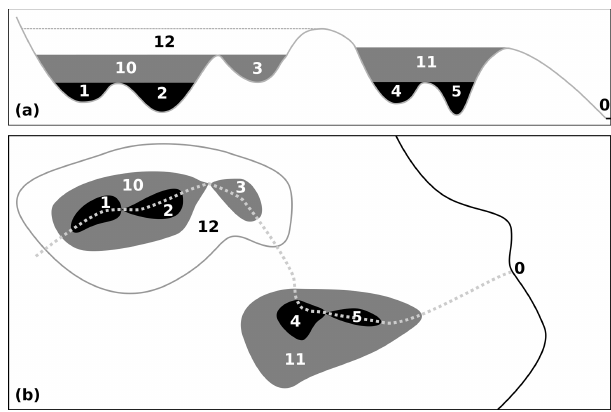
Figure 3. Cartoon of the left-hand side of the depression hierar- chy from Figs. 1 and 2. In this case, we consider depressions to be represented in topography. (a) Cross-sectional view. (b) Map view. Numbering follows Figs. 1 and 2. Flood-fill algorithms used for depression-filling would simply fill these depressions to the high- est levels (labeled 11 and 12); the direction of flow and the structure within each depression would not be considered.